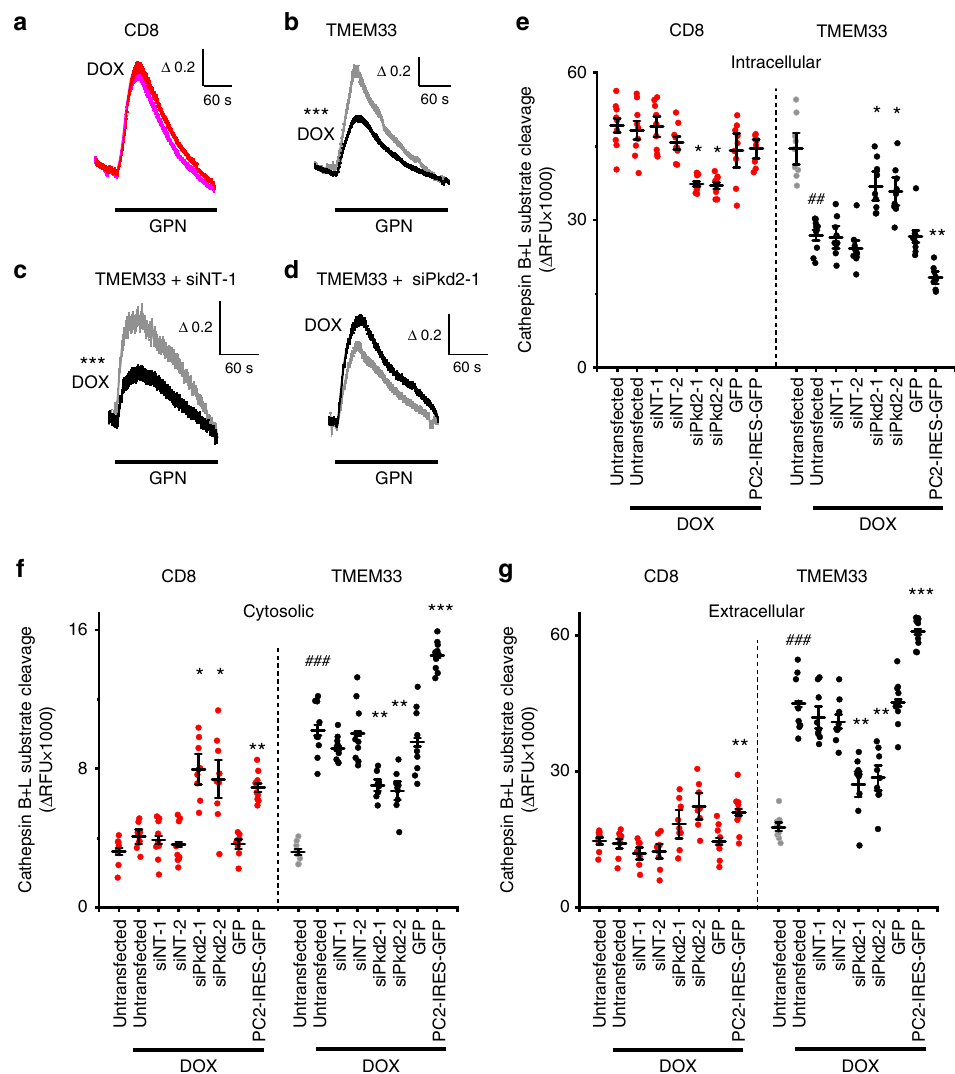
Fig. 4 TMEM33 inhibits endolysosomal calcium re fi lling and induces cathepsins translocation. a Increases in cytosolic calcium concentration are expressed as ratios of 340:380 nm fl uorescence signals ( Δ R/R 0 ). GPN (250 μ M) response in the absence of extracellular calcium in a conditional PCT cell line expressing CD8ER in the presence of DOX (magenta trace, n = 692), as compared to the non-induced condition (red trace; n = 706). b Same in a conditional PCT cell line expressing TMEM33 in the presence of DOX (black trace; n = 548) or without induction (gray trace; n = 620). c GPN response in cells transfected with siNT ( n = 204 and n = 224, in the absence [gray trace] or the presence of DOX [black trace], respectively). d Knockdown of Pkd2 (coding for PC2) suppresses the effect of TMEM33 ( n = 361 and n = 422 in the absence and in the presence of DOX, respectively). e Effect of Pkd2 knock- down or PC2 overexpression on intracellular cathepsins B/L content. CD8: red dots; TMEM33 non induced: gray dots; TMEM33 induced: black dots. f Same for cytosolic cathepsins. g Same for extracellular cathepsins. Values represent average peak Δ RFU values for n = 3 independent transfection experiments done in triplicate. * compared to respective untransfected DOX induced controls and # compared to respective non-induced controls. Bars are means Δ RFU ± SEM overlaid with dot plots for e-g. One star indicates p < 0.05, two stars p < 0.01 and three stars p < 0.001, with a Student ’ s t-test used to evaluate statistical signi fi cance. Source data are provided as a Source Data fi